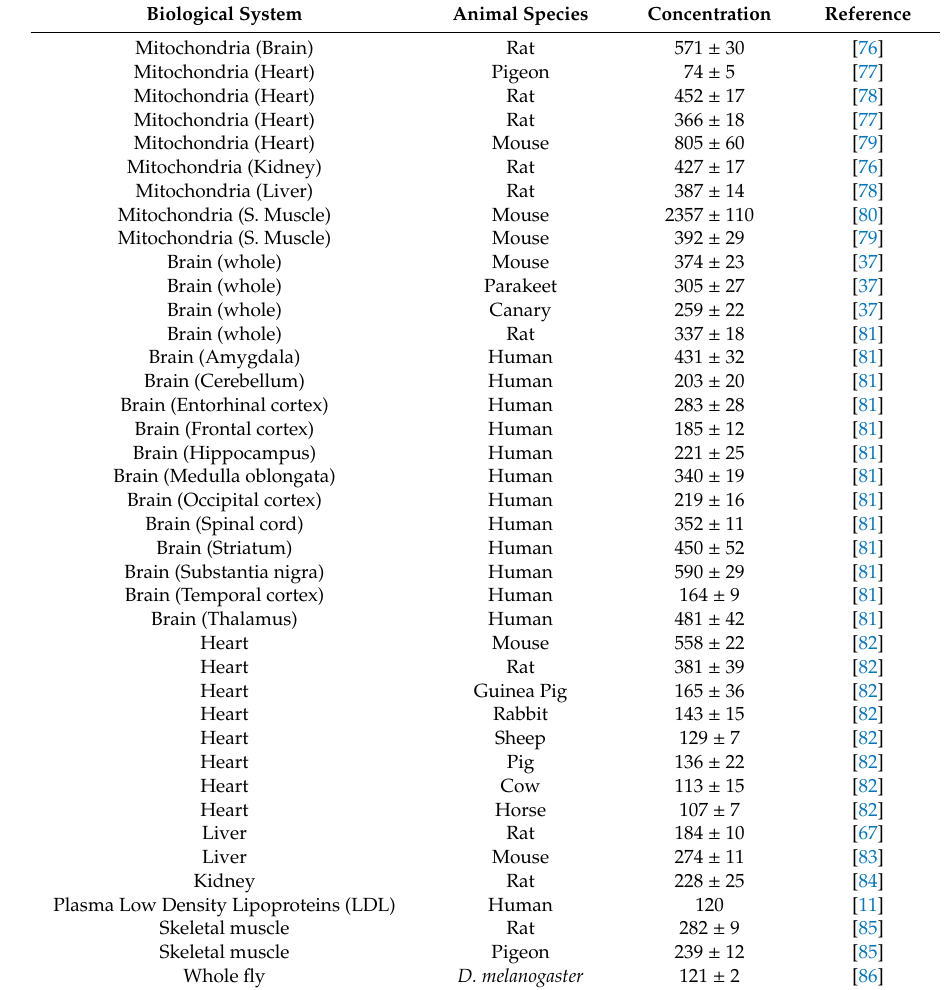
Table 2. Steady-state levels of MDALys measured by GC / MS in di ff erent tissues and